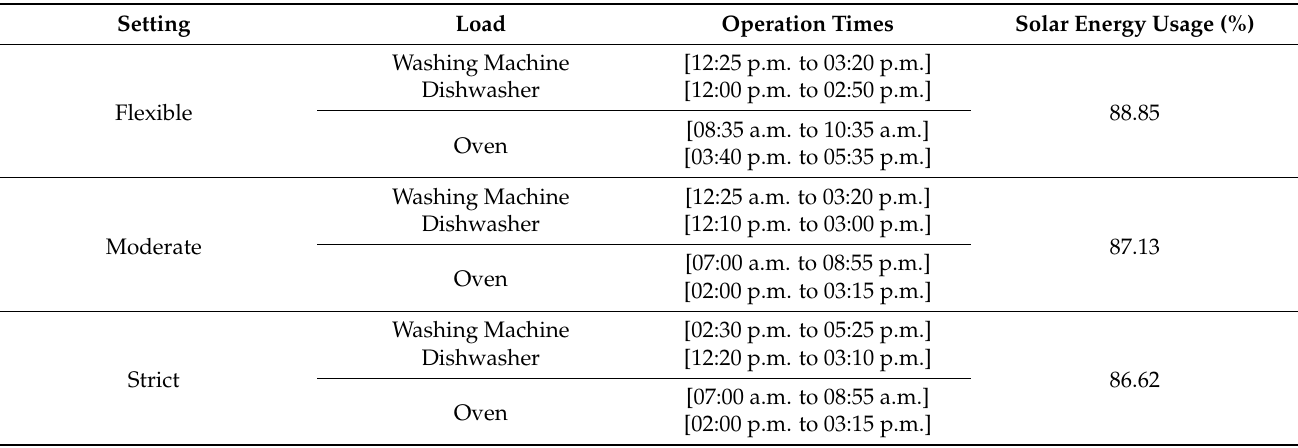
Table 5. Result Summary for Scenario